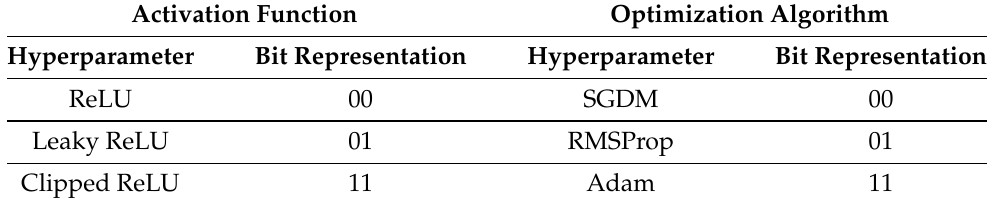
Table 2. Encoding rule for